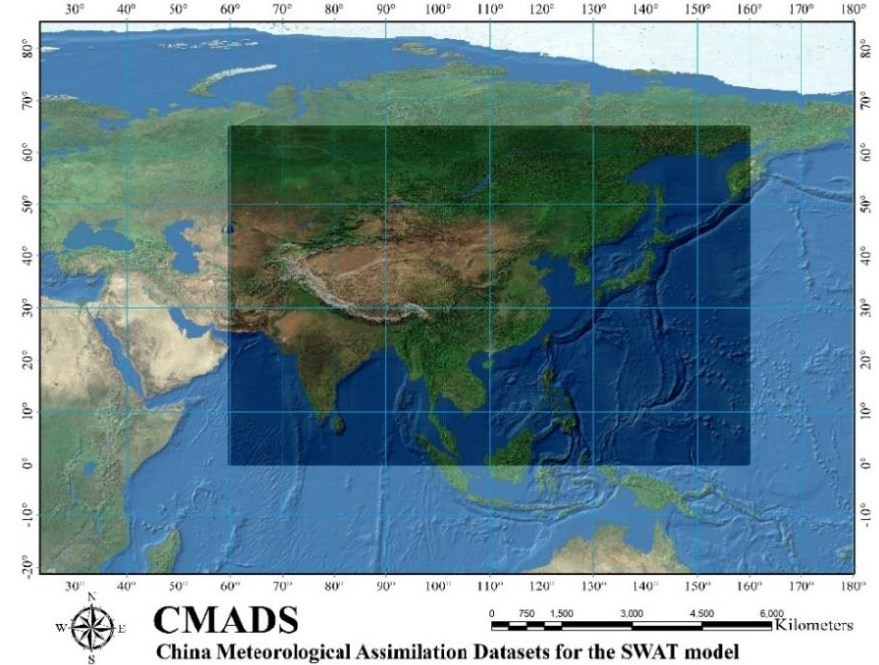
Figure 1. The spatial range of the